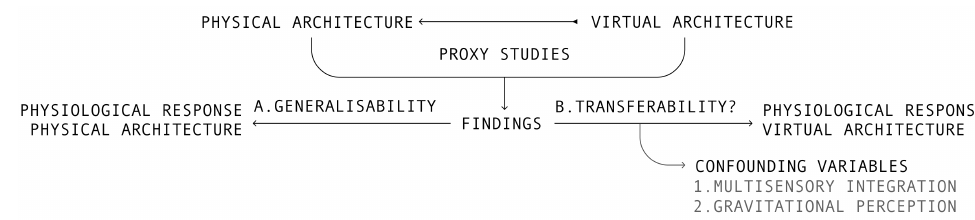
Figure 1. This proxy relational diagram illustrates the current state of the research examining the relational dynamics between proxy studies, physiological responses to PA and physiological responses to VA. Left: highlights the established generalisability between VA and PA, whereby VA is used to test physiological responses to PA. Right: illustrates the primary research question of this paper: can findings from proxy studies be transferred to understand physiological responses to VA? The diagram identifies the two proposed confounding variables, multisensory integration and gravitational perception, that problematise the prospect of transferability. Multisensory integration refers to the interaction between sensory inputs and the combination of their information content. While gravitational perception refers to the intersensory schema required to accurately perceive gravitational